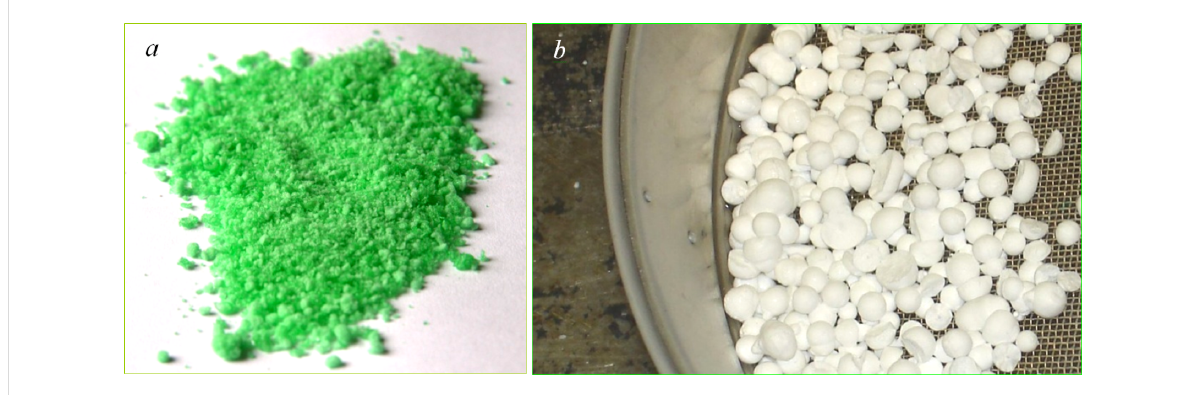
Figure 2: Photographs of the cryogel, which is a precursor of the NiO nanopowder (a) and the cryogranulate, which is a precursor of the sodium nitrate powder (b).